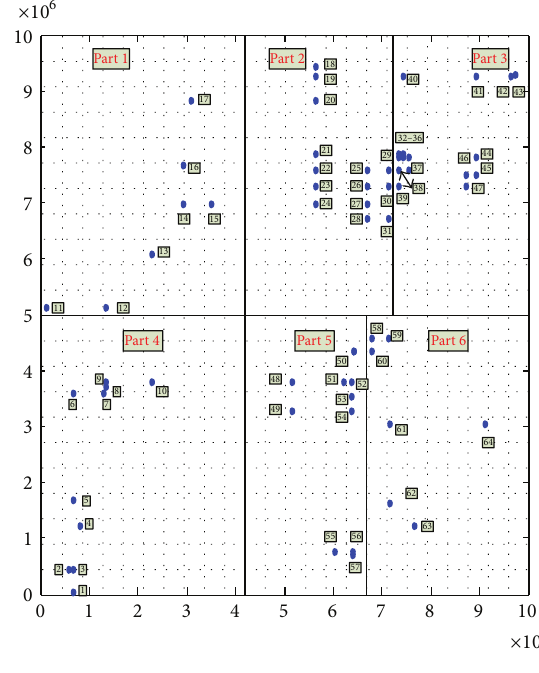
Figure 10: Example of 64